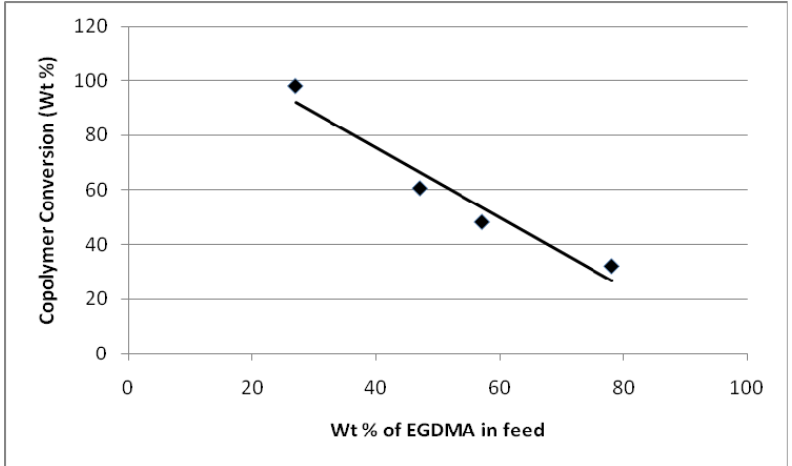
Figure 19. Copolymer conversion (wt %) vs. wt % of MMA in